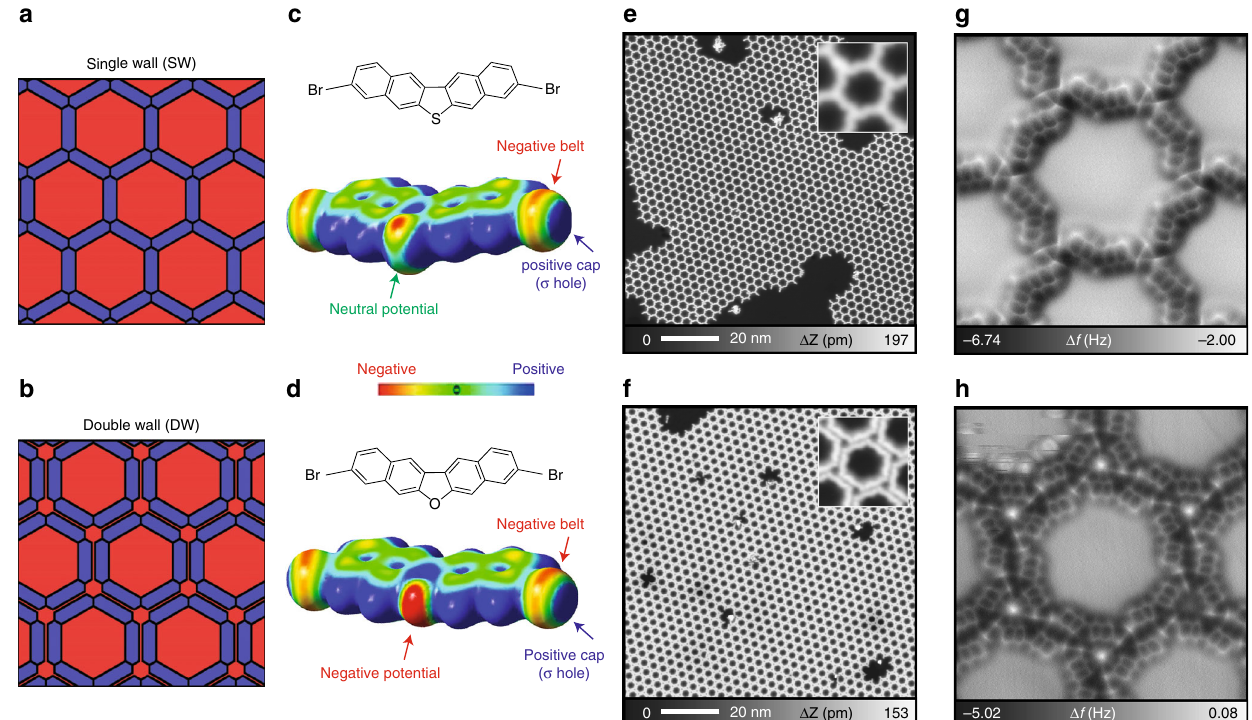
Fig. 1 QD arrays generated by single-wall (SW) and double-wall (DW) nanoporous networks that con fi ne the surface 2DEG. a , b Schematic representations of the concept behind SW and DW networks. c , d Chemical structures and electrostatic potential maps of Br-DNT and Br-DNF. e , f Large- scale STM topographies for the SW network with Br-DNT and the DW network with Br-DNF. Insets show close-views of each network. g , h High resolution atomic force microscopy (AFM) images of the SW network and DW network. Measurement parameters: tunneling current I = 5 pA, bias voltage V = 200 mV ( e , f ); V = 0 mV, oscillation amplitude A = 60 pm ( g , h